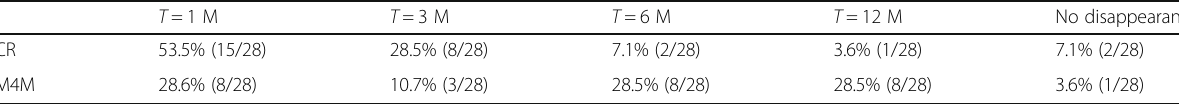
Table 4 Disappearance of the overfilling. Unit: % T = 1